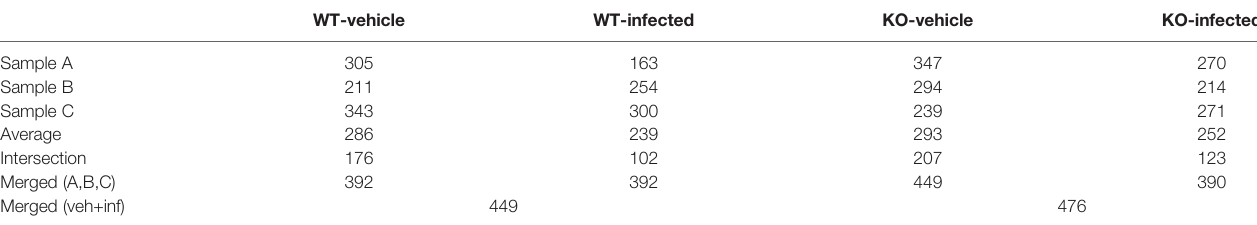
TABLE 2 | Summary of CMPs in original samples and created data sets.